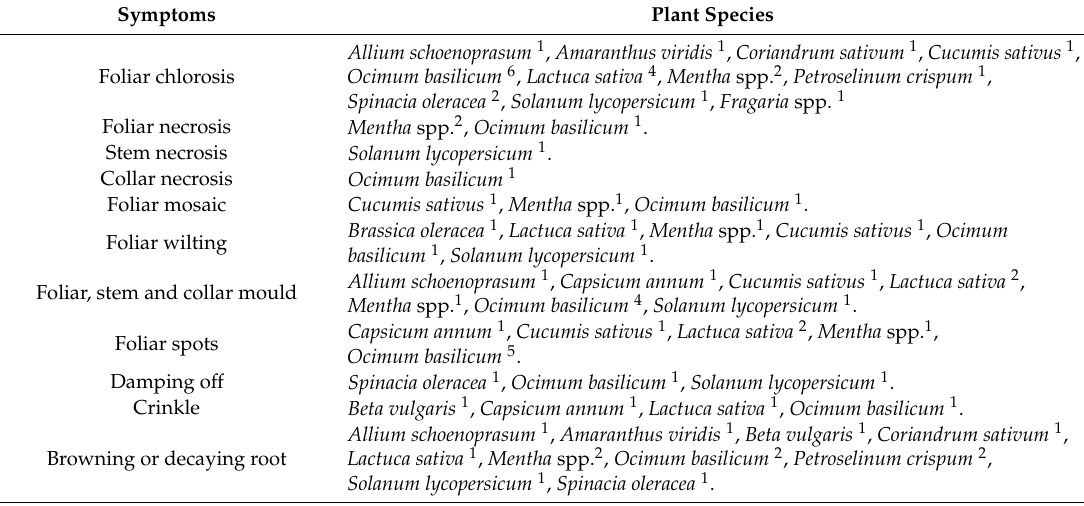
Table 2. Common symptoms summarized from 2018 international survey analysis in aquaponics